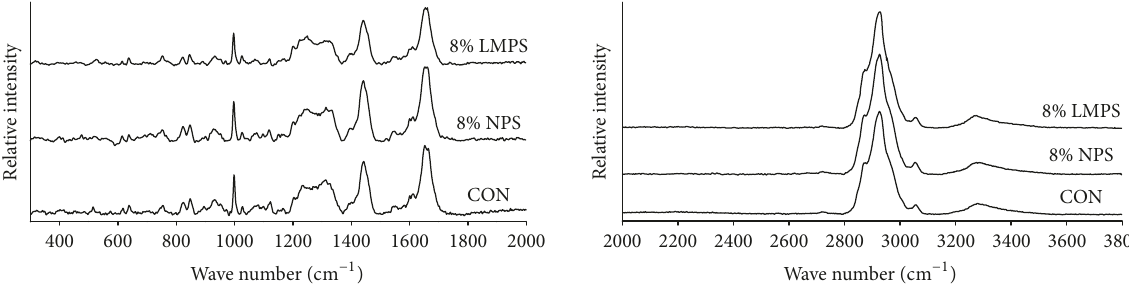
Figure 2: The Raman spectra of surimi gel. CON (control, i.e., pure surimi gel), NPS (surimi gel with native potato starch), and LMPS (surimi gel with low-moisture potato